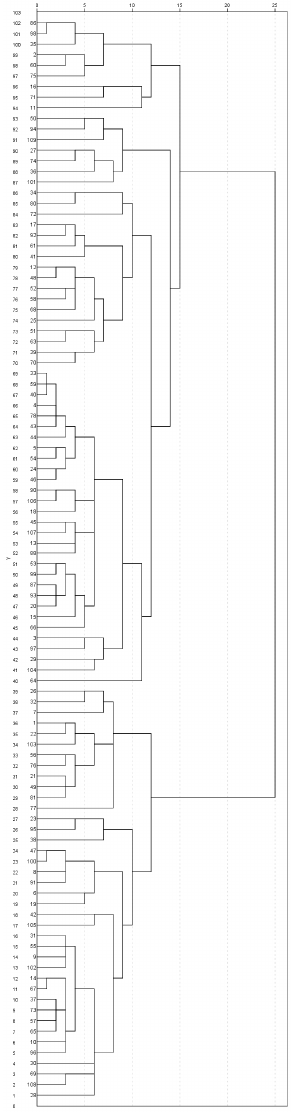
Figure 1. Cluster Figure 1. Cluster dendrogram.